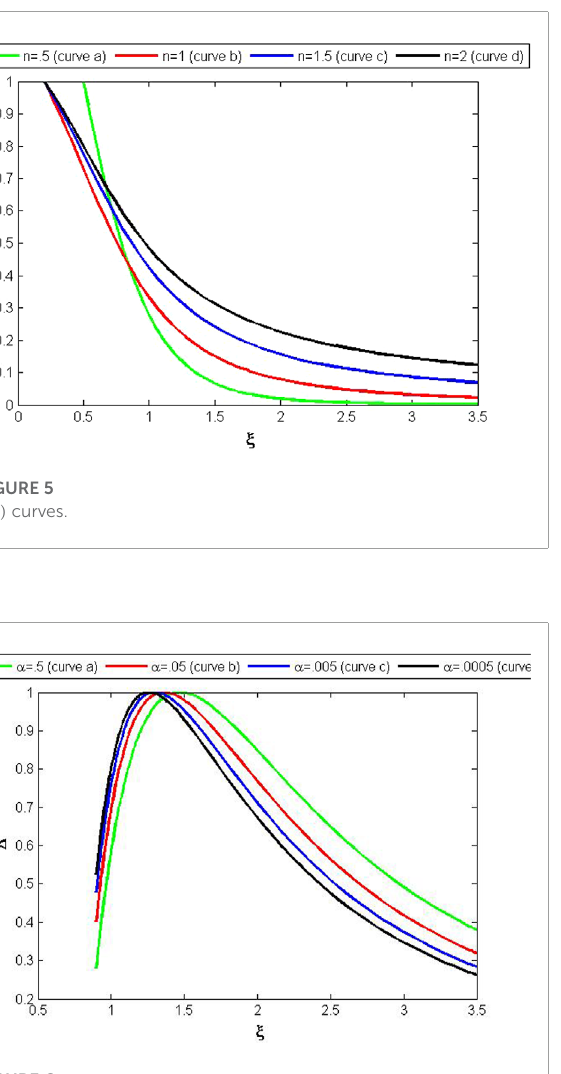
FIGURE 6 Δ( ξ ) curves.